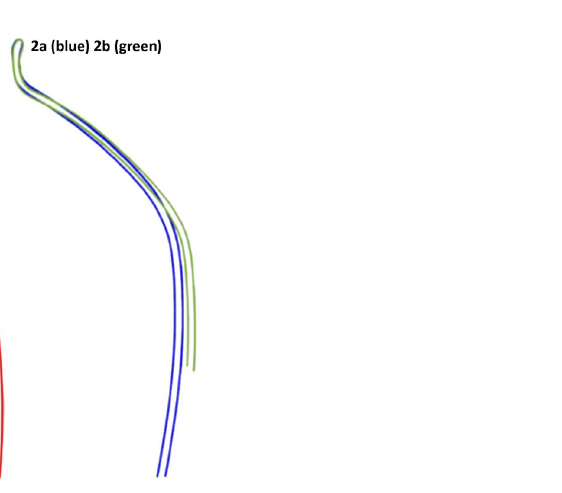
Fig 9. An average profile of the two main branches (Types 1 and 2) and their subtypes (1a, 1b and 2a, 2b).